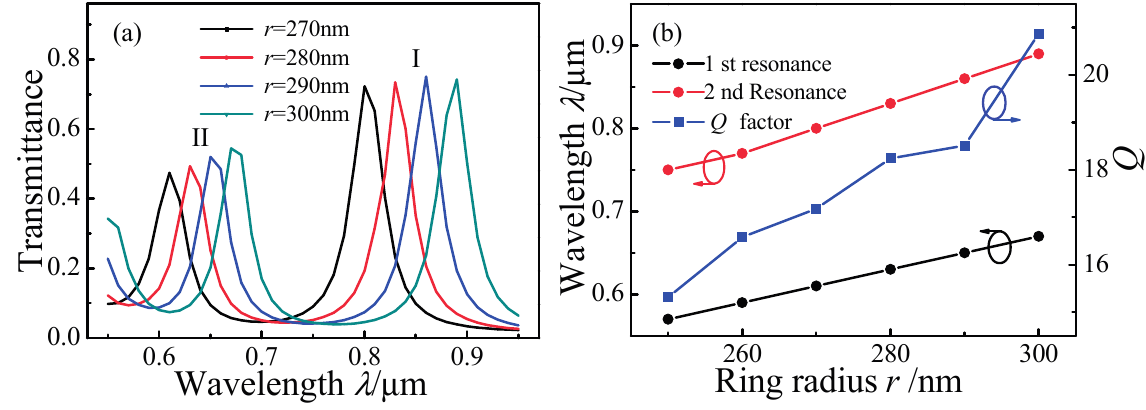
Figure 4. Simulated transmission spectra of MIM waveguide-coupled ring resonators as a function of radius r : ( a ) Spectra for r = 270 nm, 280 nm, 290 nm, and 300 nm; ( b ) Dependence of peak positions and Q factor on r .